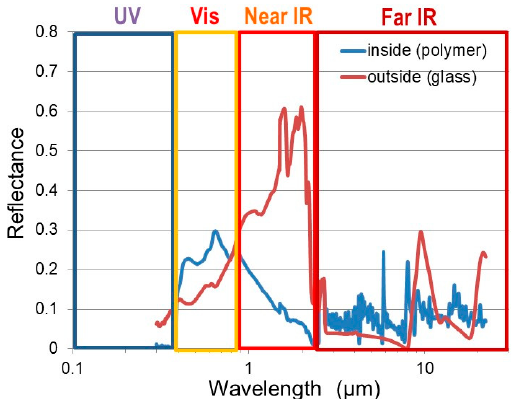
Figure 6. Reflectance of full-size OPV sheet as a function of wavelength as calculated using Japanese Industrial Standards R 3106 and A 5759.